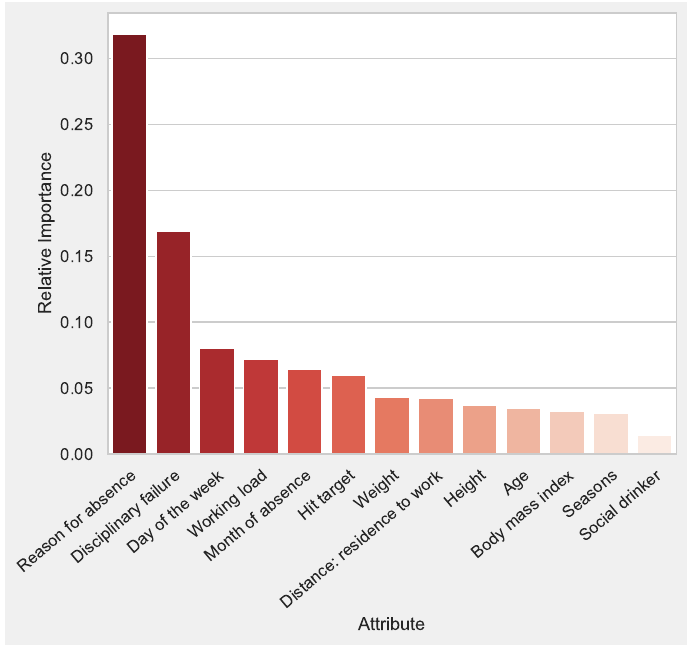
Figure 4. Relative importance of the individual